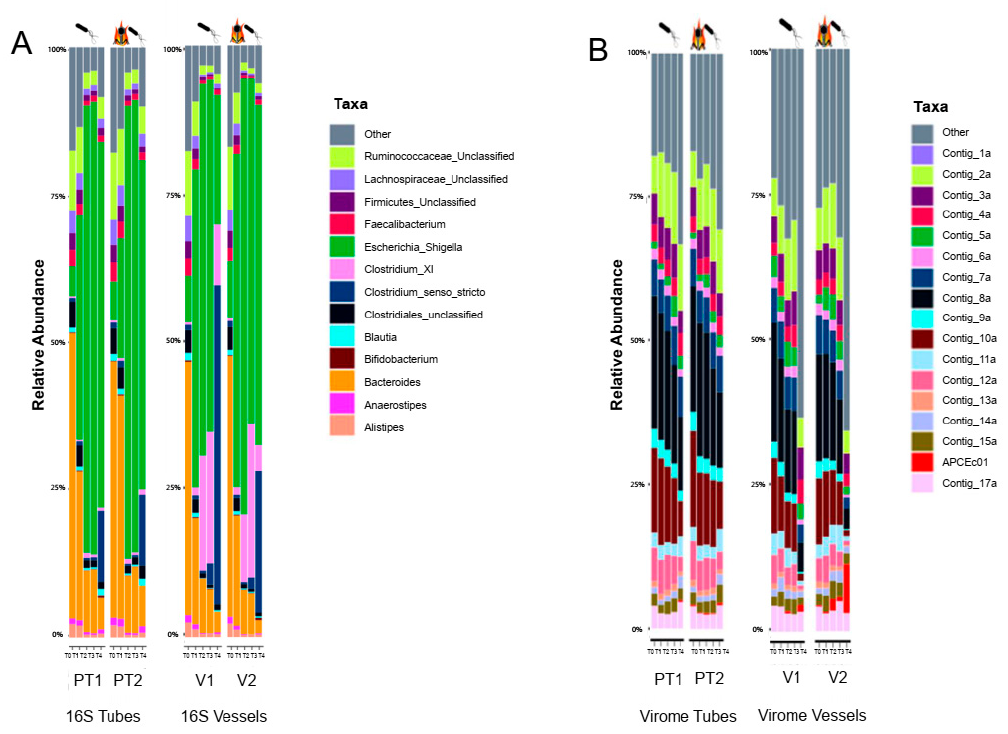
Figure 2. Sequencing results of faecal fermenter tubes and vessels during treatment 2 ( E. coli APC106 addition vs. E. coli APC106 + heat-killed Φ APCEc01 addition, FSI batch2) ( A ) stacked bar plots showing different bacterial abundances on genus level ( B ) stacked bar plots showing different viral